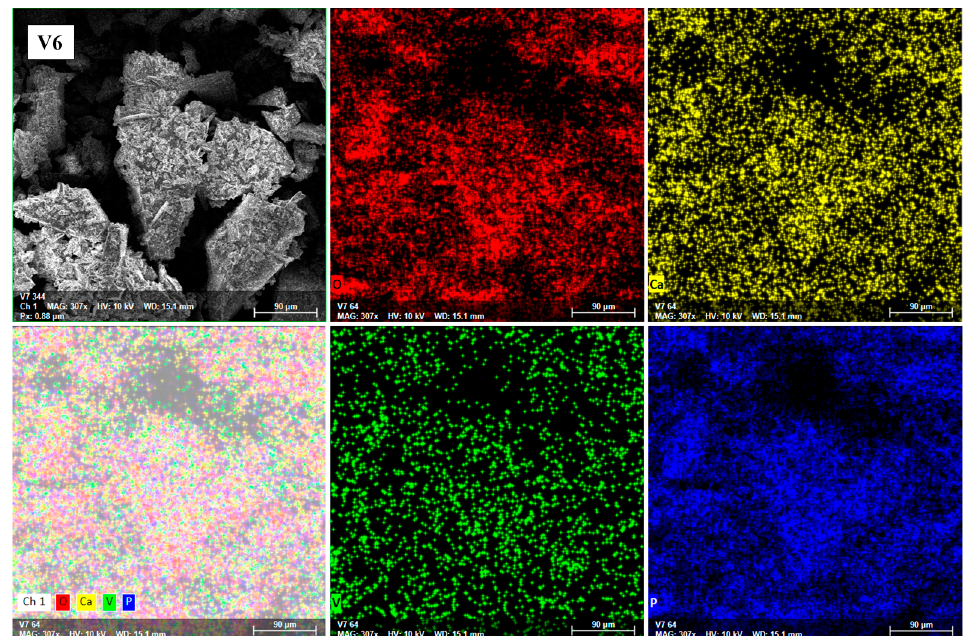
Figure 4. EDS mapping of O (red), Ca (yellow), V (green), and P (blue) of glass powder with x = 8 mol% V 2 O 5 before the dissolution experiments. 2.1.4. EPR The EPR spectra of a vanadium-doped xV 2 O 5 ∙ (100 − x) [CaF 2 ∙ 3P 2 O 5 ∙ CaO] glass system with 0 ≤ x ≤ 16 mol% are presented in Figure 5A.